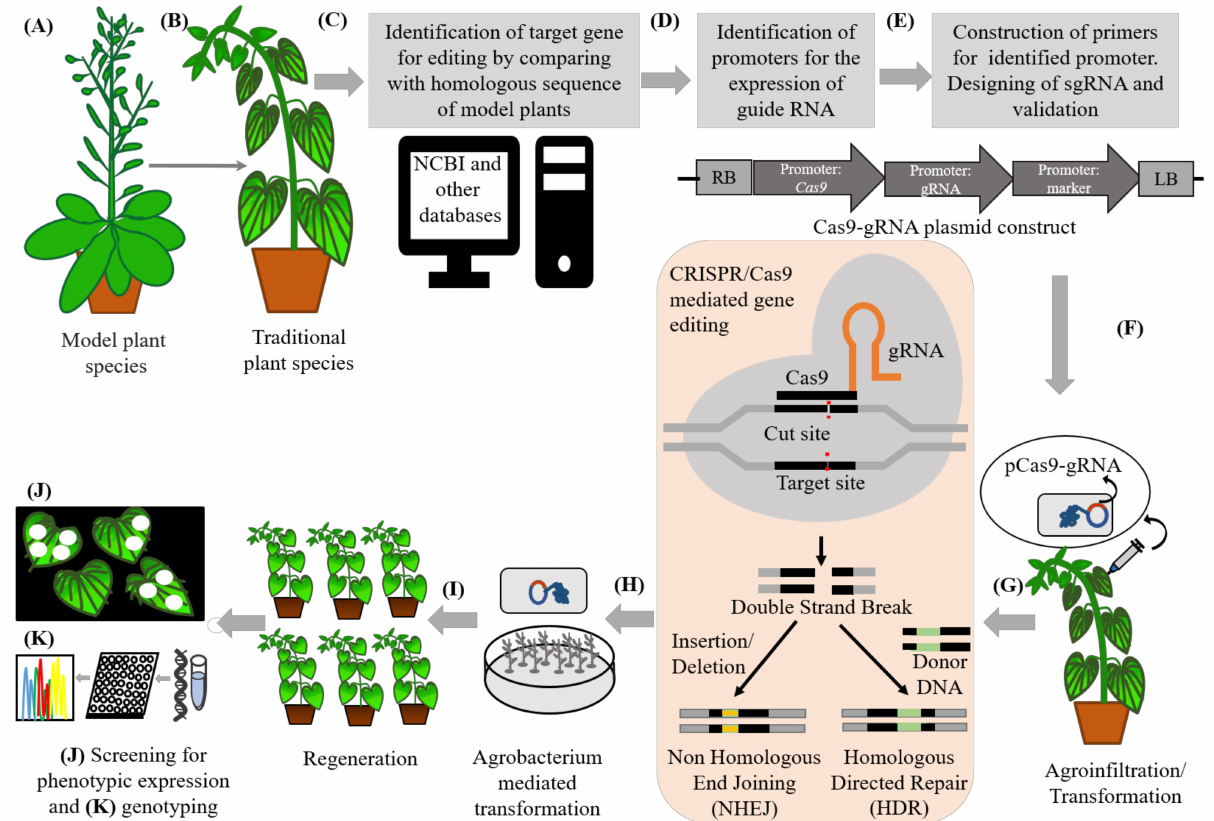
Figure 3. General workflow of CRISPR/Cas9 based gene editing in neglected crops for their improvement. ( A ) Extensively studied model plant species chosen for the ease of identification of homologous genes governing particular traits. ( B ) Underutilized, orphan or neglected traditional plants with undesirable traits can be edited for trait improvement, and biotic and abiotic stress tolerance. ( C ) Identification of target gene(s) for construction of sgRNA by comparing with a homologous sequence of model plants using databases such as the National Center for Biotechnology Information. ( D ) Identification of promoters for the expression of guide RNA. ( E ) Construction of plasmid carrying Cas9, gRNA and reporter gene in the promoter region with software Cas-Designer. ( F ) Agroinfiltration on young leaves with Agrobacterium harboring the construct Cas9-gRNA-Reporter. ( G ) Induction of precise breaks at the target sequence site(s). Endogenous machinery of cells repairs the breaks by non-homologous end joining (NHEJ) in the absence of a homologous repair template resulting insertions/deletions (indels) that disrupt/change/edit the target sequence or homology directed recombination by providing a homologous repair template, thereby inducing genomic mutations at the target locations. Other than CRISPR/Cas9 zinc finger nucleases (ZNF), mega nucleases and transcription activator-like effector nucleases (TALEN) are also used for gene editing, but the feasibility of CRISPR/Cas9 is greater when compared with other methods. ( H ) Validation of the efficiency of CRISPR/Cas9 for targeted mutagenesis in stable transgenic plants. The construct pCas9-gRNA- reporter introduced into nodal-explants after tissue culture using the Agrobacterium-mediated transformation method. ( I ) Regeneration of stable transgenic plants. ( J ) Screening of the regenerated plants for the mutated effect by checking their phenotypes. ( K ) Genotyping or putative transgenic plants containing Cas9 confirmed by PCR analysis